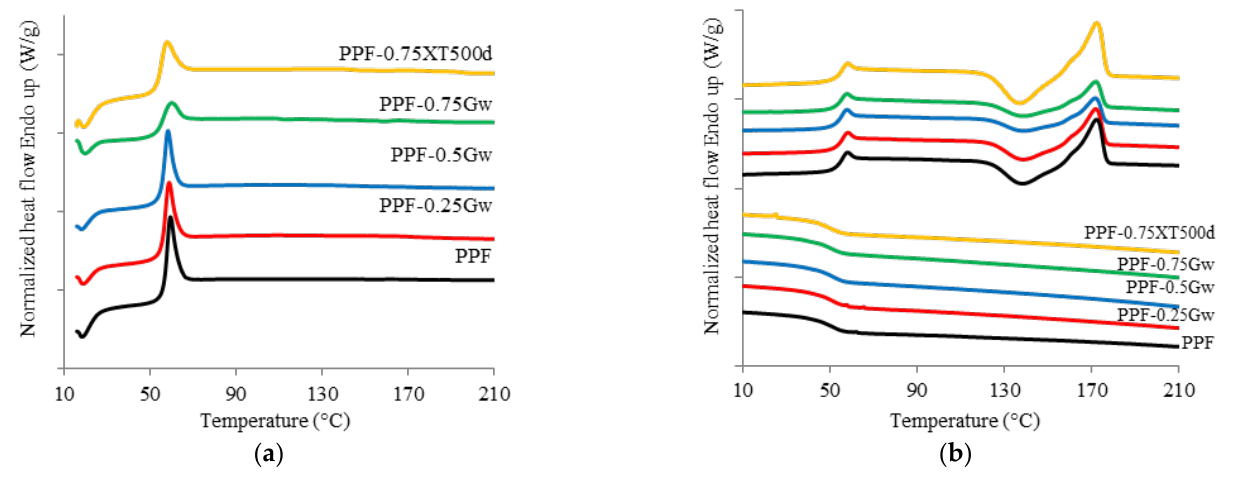
Figure 4. ( a ) Calorimetric curves of PPF and PPF composites with graphene, first heating scan; ( b ) second heating scan and cooling scan.